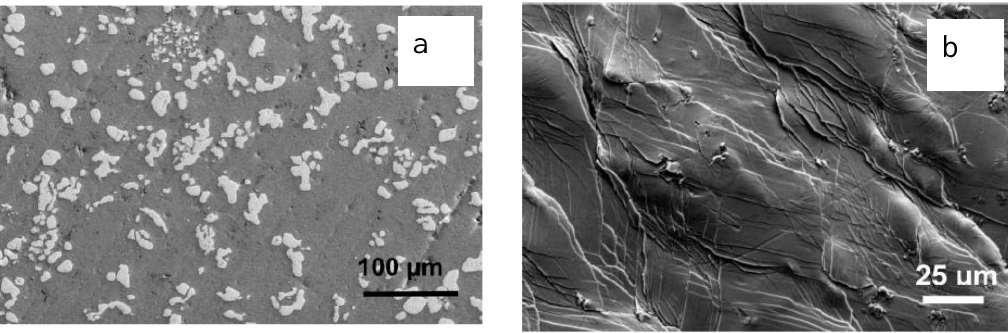
Figure 7. ( a ) A scanning electron micrograph showing Ta particles dispersed in a La Al Cu Ni glassy matrix. ( b ) Multiple shear band offsets can be seen on samples 55 25 10 10 tested under compression, which reach strains up to 40% (reproduced from